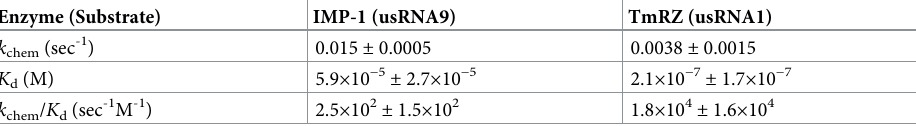
Table 1. Kinetic parameters obtained from single-turnover assay.